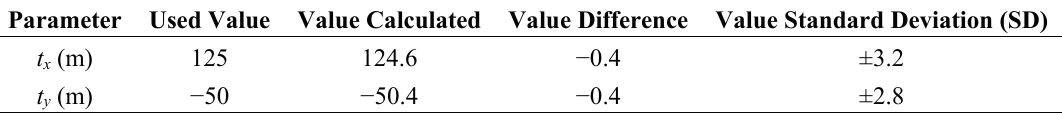
Table 1. Statistical numerical values of the proposed registration algorithm carried out on synthetic data (values in